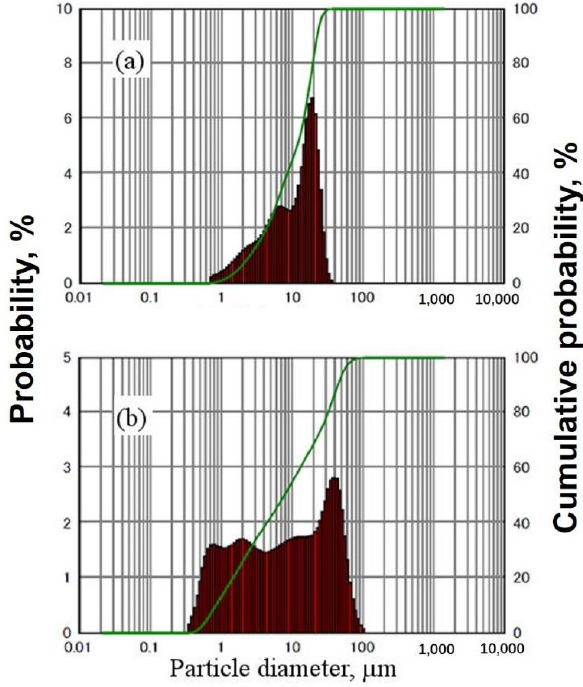
Figure 5. Particle size distribution: ( a ) powder A and ( b ) powder B.